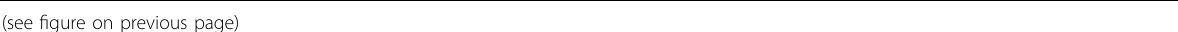
Fig. 3 Coexpression of macrophages and lymphatic vessel cells in vivo and in vitro. Colocalization of F4/80 + macrophages and LYVE-1 +